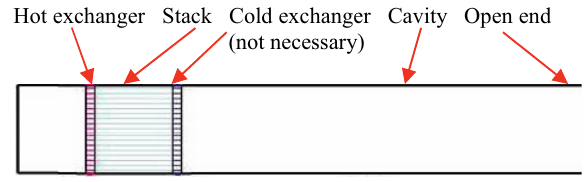
Figure 2. Schematic of thermoacoustic engine In thermoacoustic heat pumps and refrigerators (Figure 3), is acoustic energy (cid:9)(cid:7)(cid:3) , that is produced for example by loudspeaker or by another thermoacoustic (cid:2)(cid:3) engine, used to pump heat (cid:8)